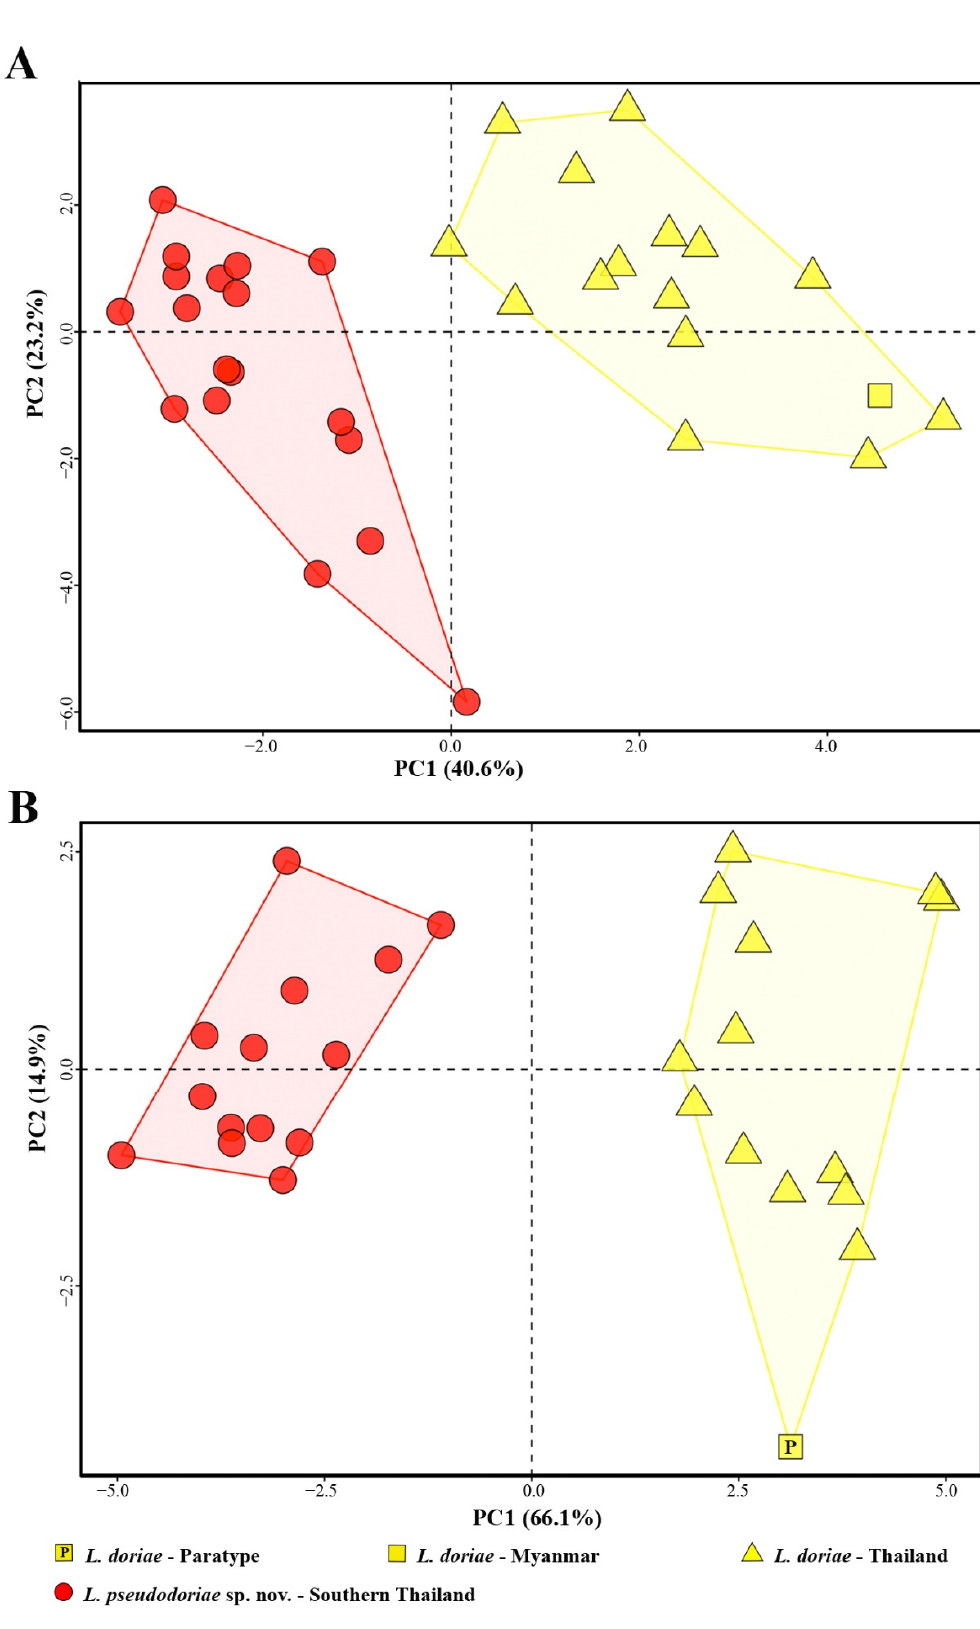
Figure 3. Scatter plot of the first (PC1) and second (PC2) principal components from principal component analysis (PCA) of morphometric measurements of ( A ) males and ( B ) females of Limnonectes pseudodoriae sp. nov . and L. doriae .